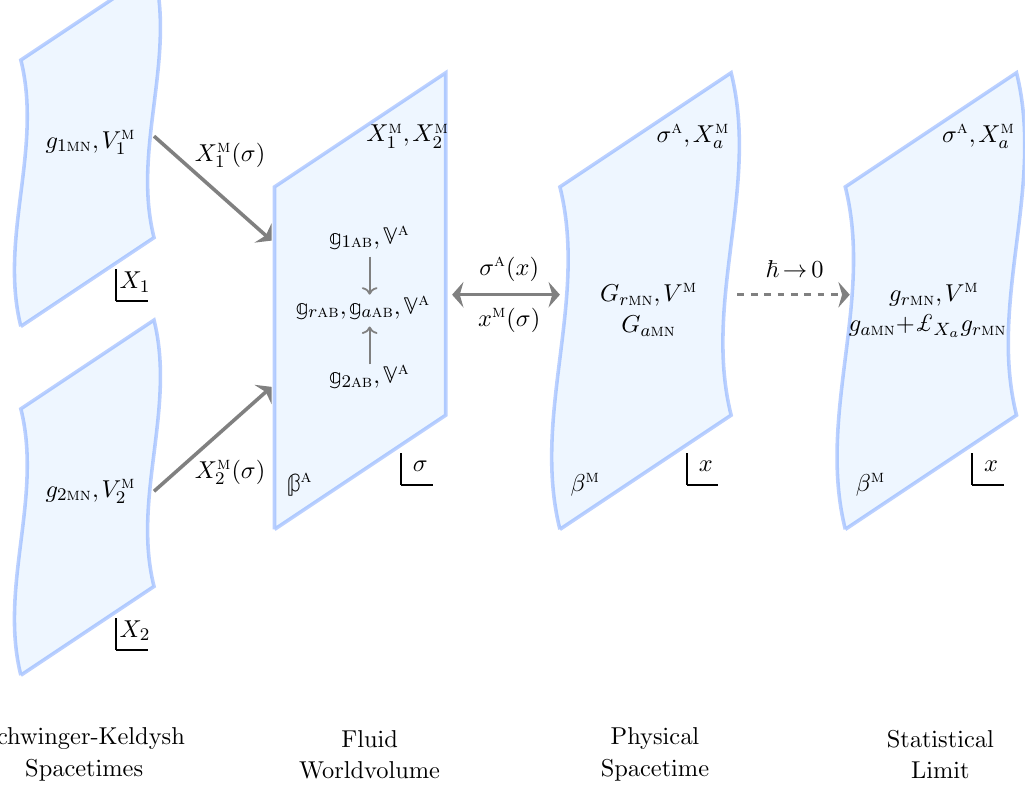
Figure 1 . Schematic representation of the e(cid:11)ective (cid:12)eld theory framework for Galilean hydrody- namics in null background